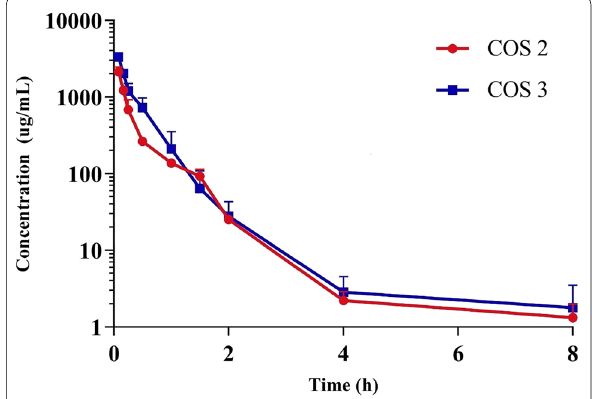
Fig. 3 Mean serum concentration–time profile of COS 2 and COS 3 in rat serum after 100 mg/kg intravenous administration ( n